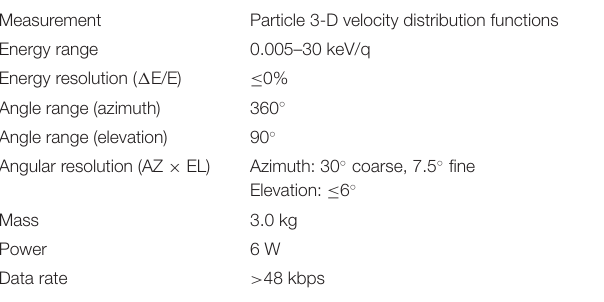
TABLE 3 | Summary of the performance of thermal plasma (ion/electron)